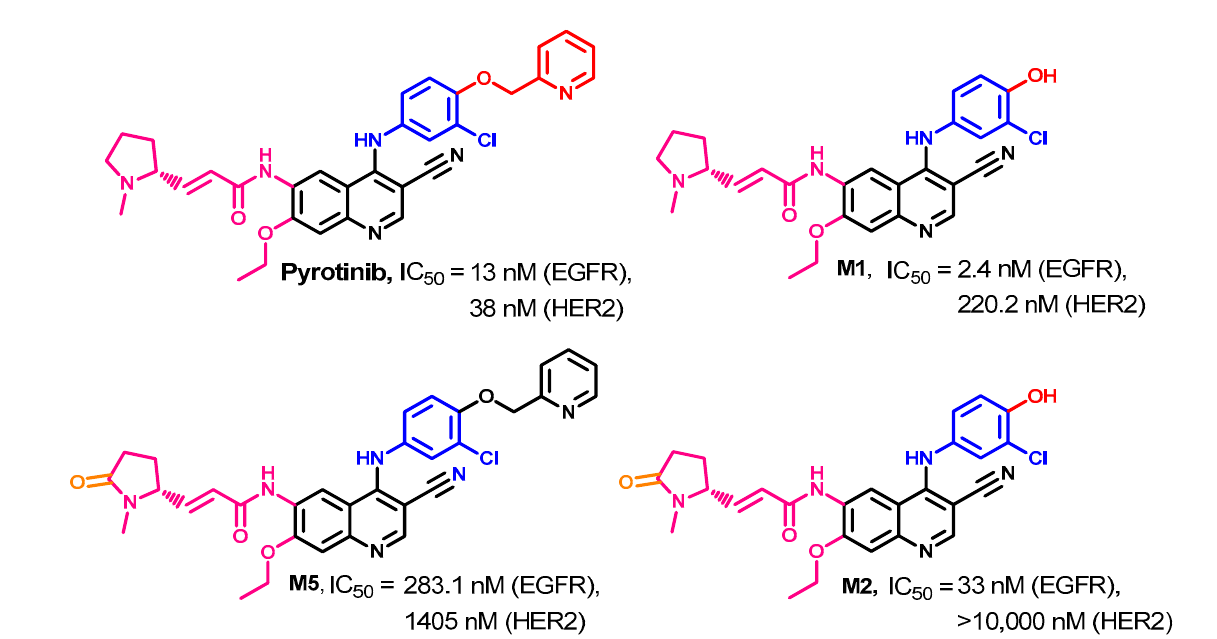
Figure 58. Kinase inhibitory activities of pyrotinib and its principal metabolites (M1, M2, and M5).